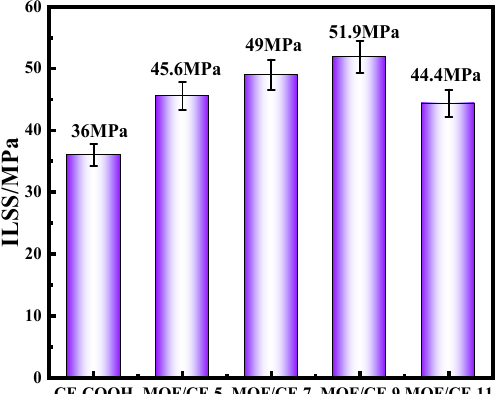
Figure 7. Interlayer shear strength of MOF/CF epoxy composites .